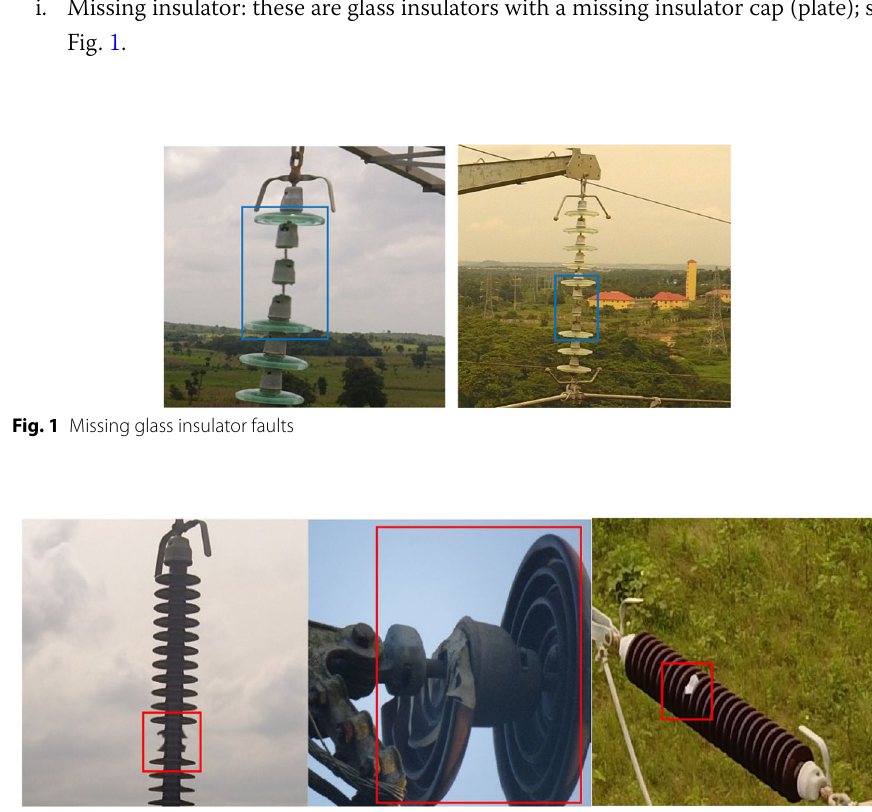
Fig. 2 Broken insulator faults prominent with the porcelain or composite plate type